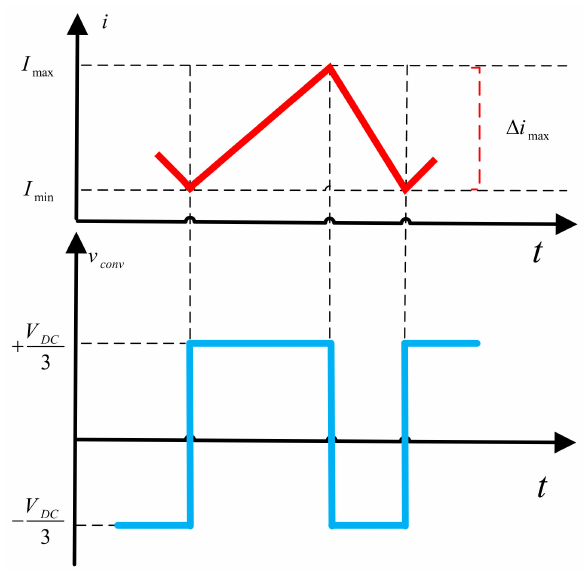
Figure 7. Current ripple by phase voltage